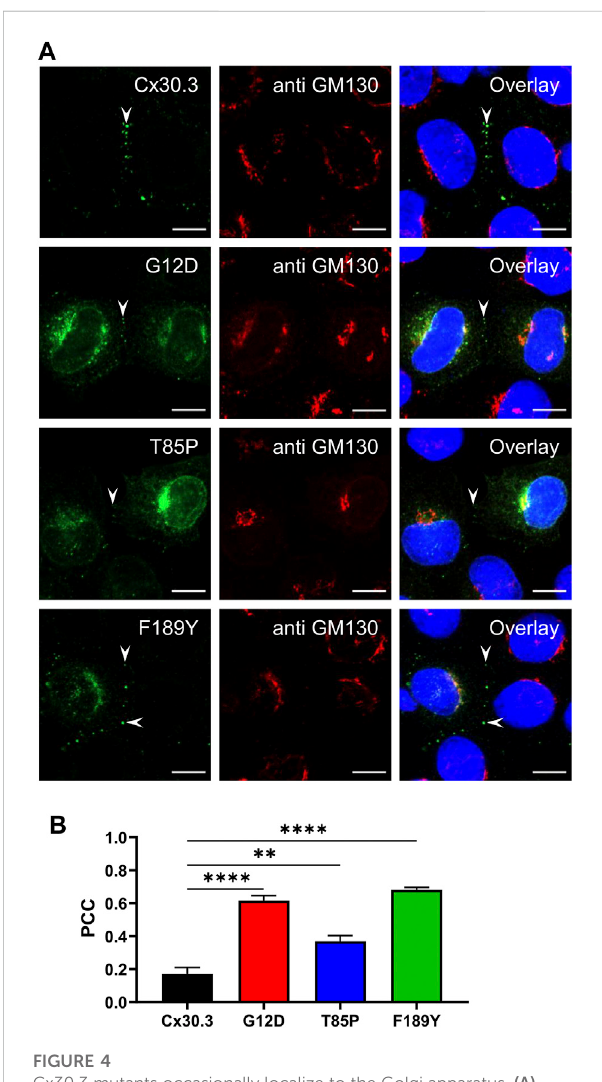
FIGURE 4 Cx30.3 mutants occasionally localize to the Golgi apparatus. (A) In some cells, FLAG-tagged Cx30.3 mutants (green) noticeably localize to paranuclear caps that stained positively for the Golgi apparatus resident protein GM130 (red). Gap junctions are indicated by arrowheads. Nuclei are demarcated by Hoechst 33342 staining (blue). Scale bars = 10 μ m. (B) Quanti fi cation by PCC revealsthattheCx30.3mutantsexhibitsigni fi